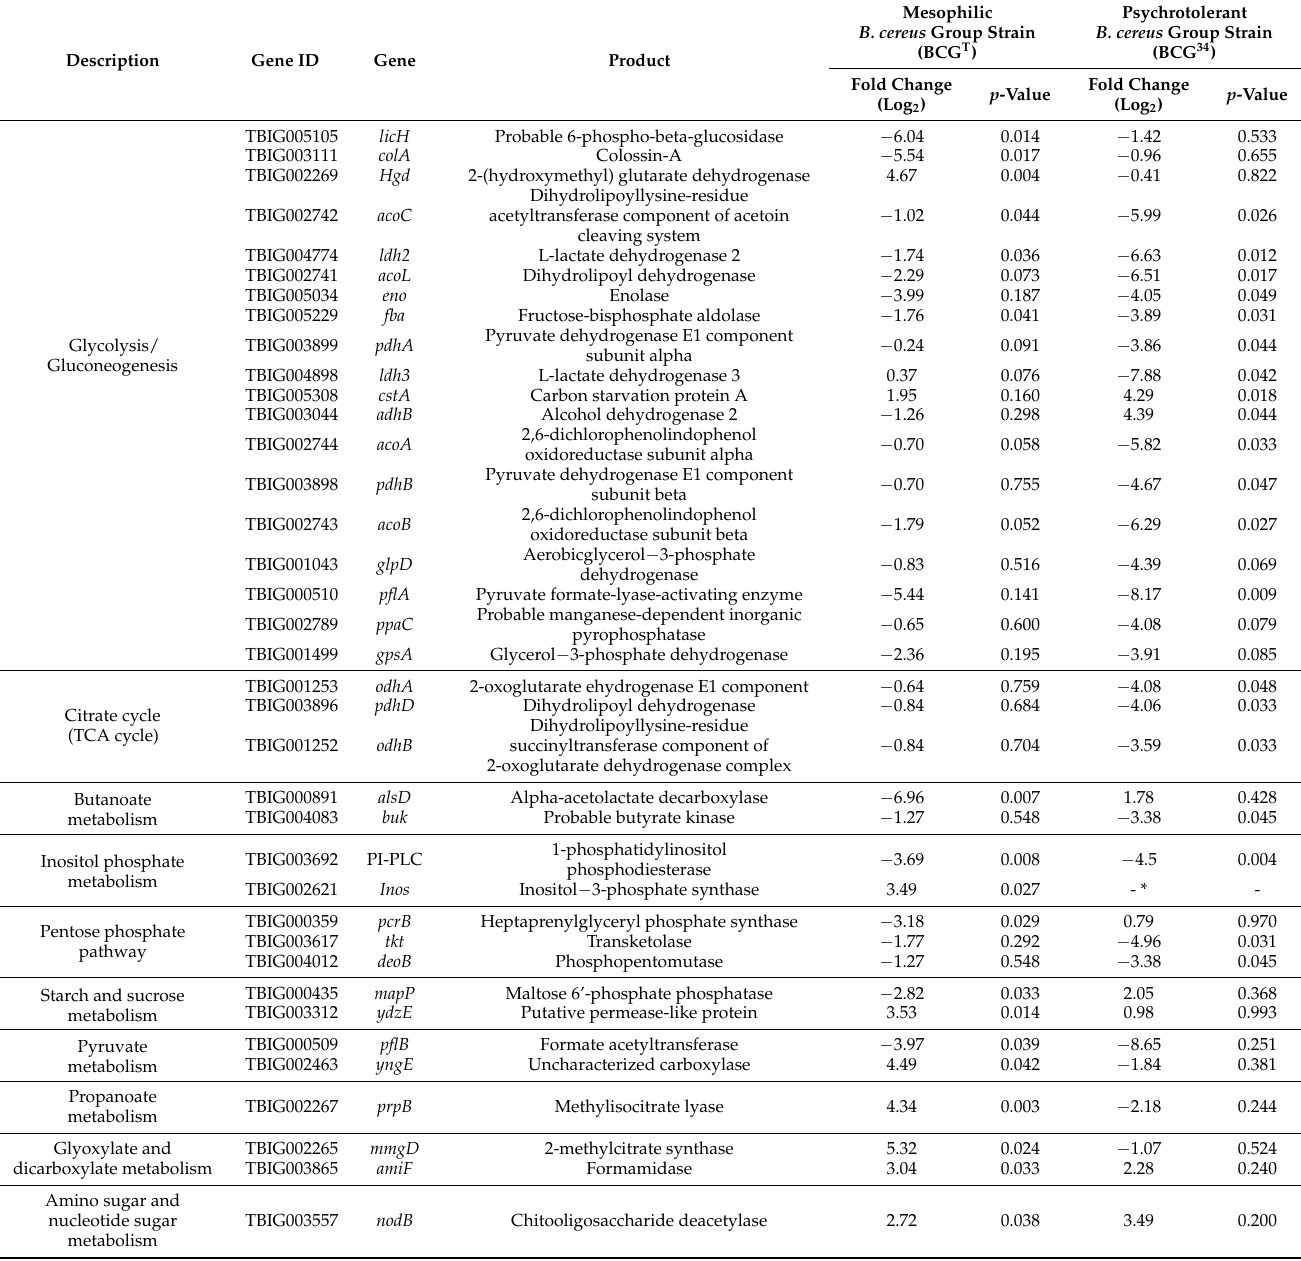
Mesophilic Psychrotolerant B. cereus Group Strain B. cereus Group Strain (BCG T ) (BCG 34